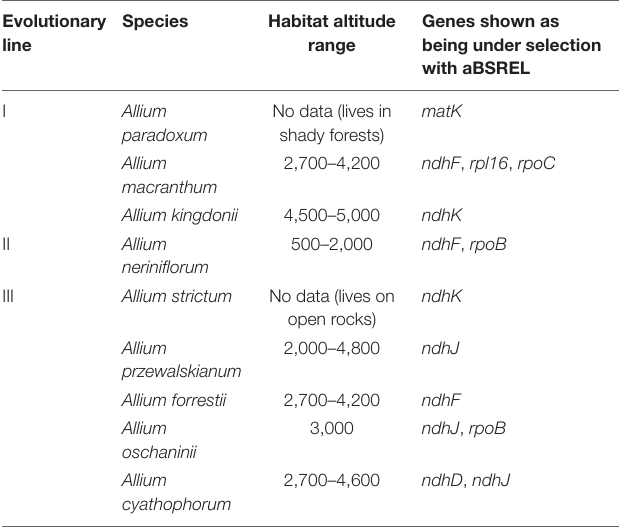
TABLE 2 | Genes and branches with selection